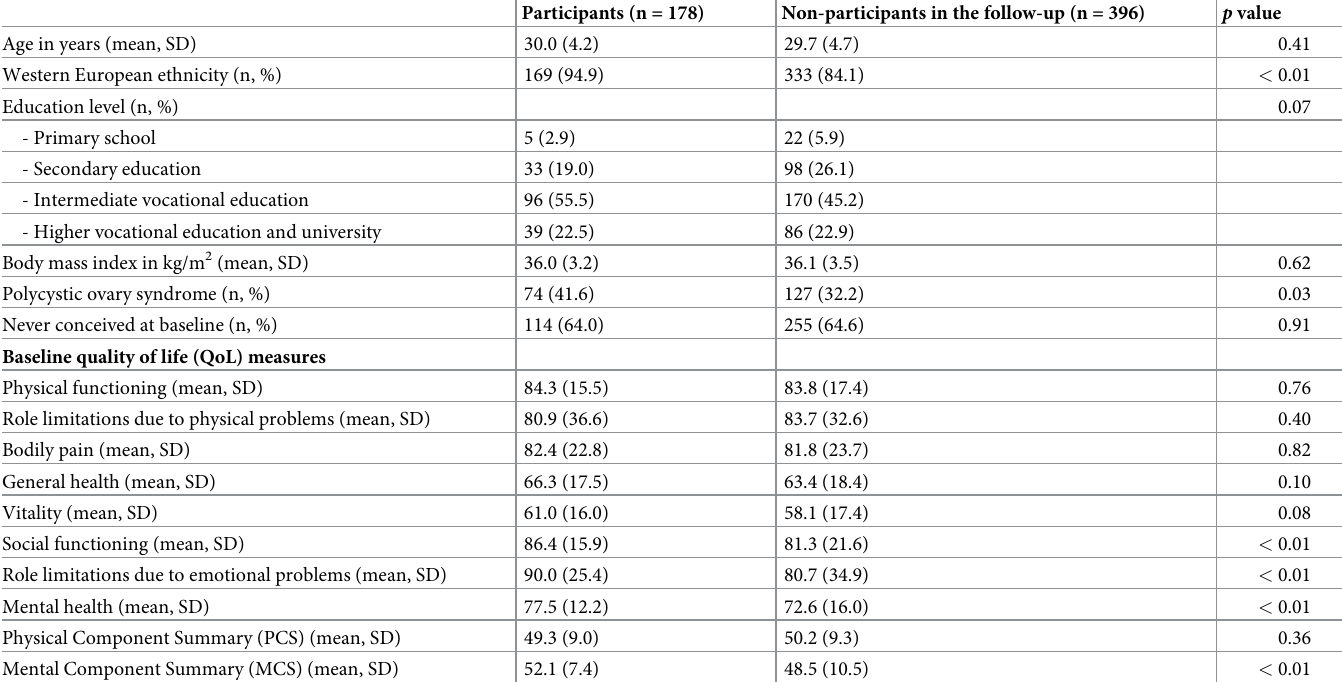
Table 1. Comparison of baseline characteristics of participants and non-participants in the follow-up of the LIFEstyle study.